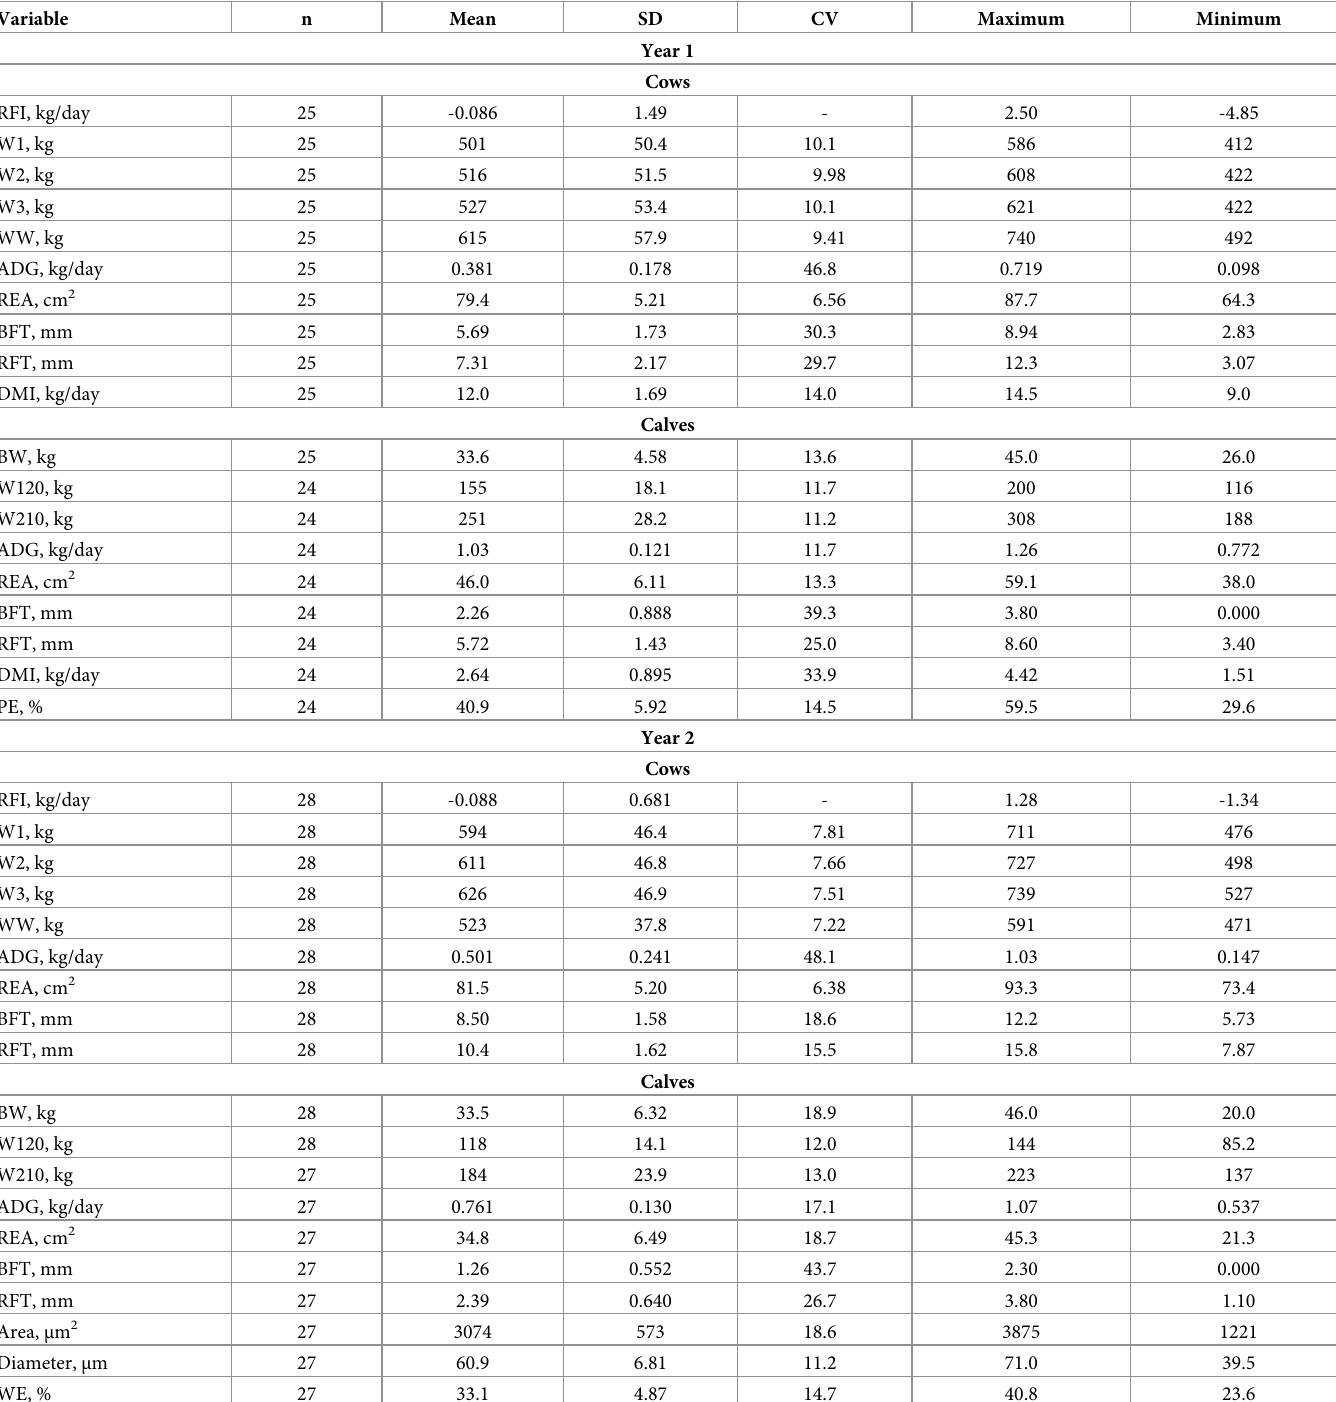
Table 5. Descriptive statistics of the variables studied in Nellore cows and calves of Years 1 and